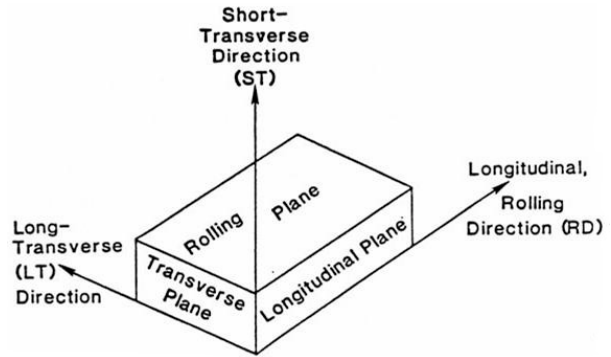
Figure 1. Schematic of different directions and planes in the as ‐ rolled 7050 aluminum alloy plate.